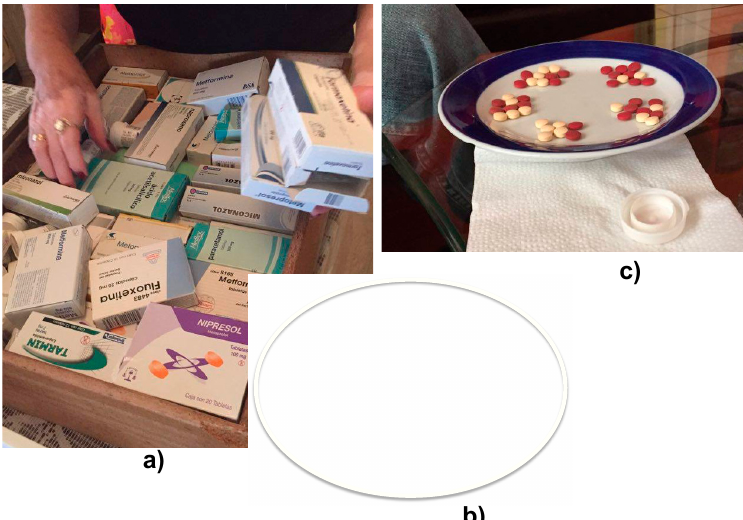
Figure 6. Unsafe medication management due to: ( a ) older adults accumulating medications; ( b ) medication containers have similar appearance and ( c ) illiterate older adults identify pills by their shape and